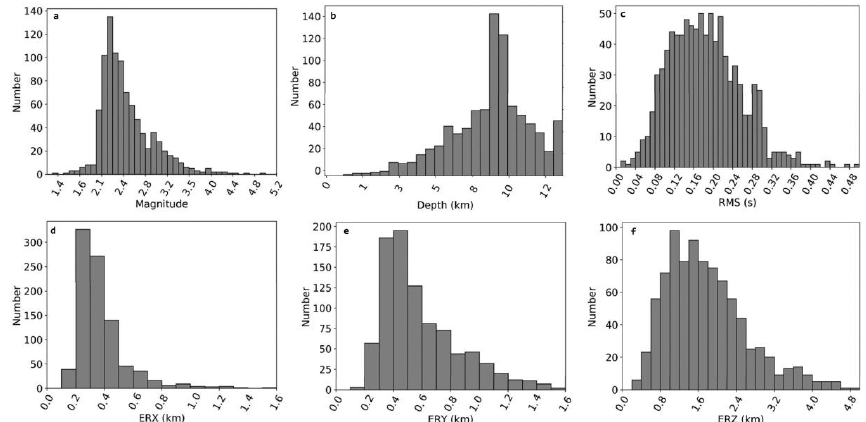
Figure 5. Descriptive statistics of the relocation procedure. ( a ) magnitude distribution, ( b ) depth